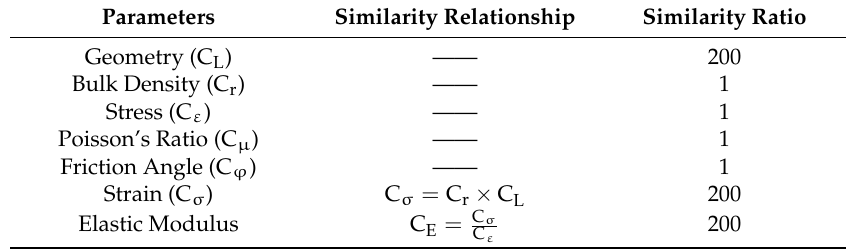
Figure 4. The side view and the completed model. Table 2. Similarity relationships of the main controlling parameters of the physical model.